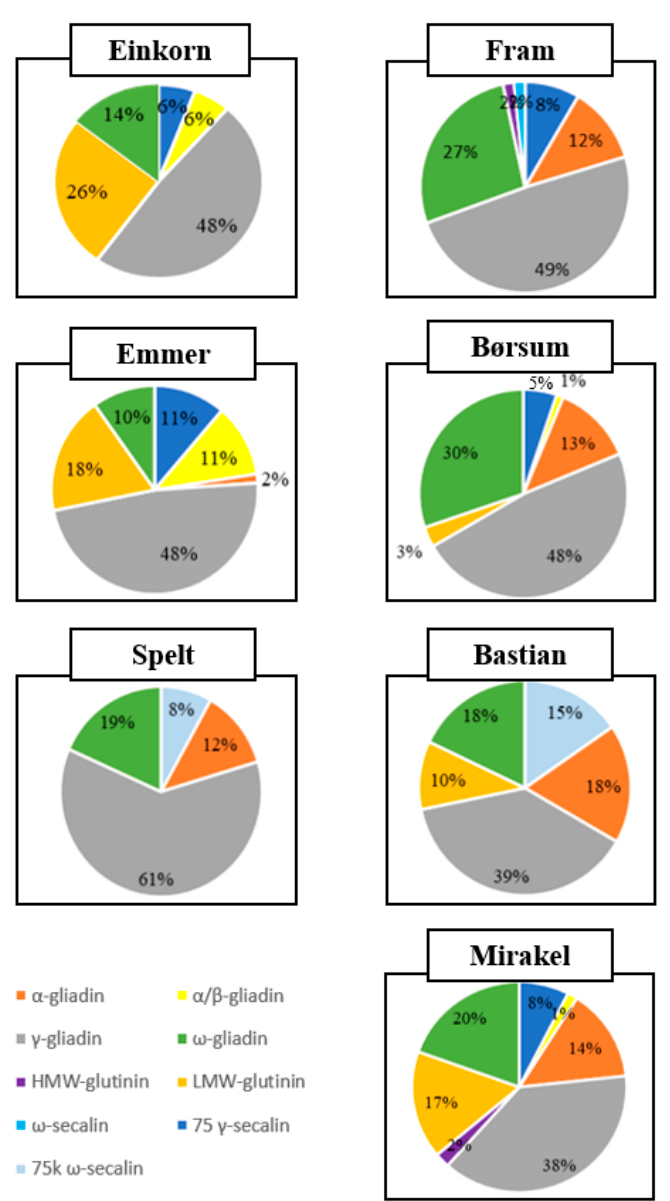
Figure 4. Diagrammatic representation of the percentage of T cell epitopes from individual parent protein subfamilies. Each protein fraction combined several different peptides with various access numbers from UniprotKB. LMW, low molecular weight; HMW, high molecular weight.